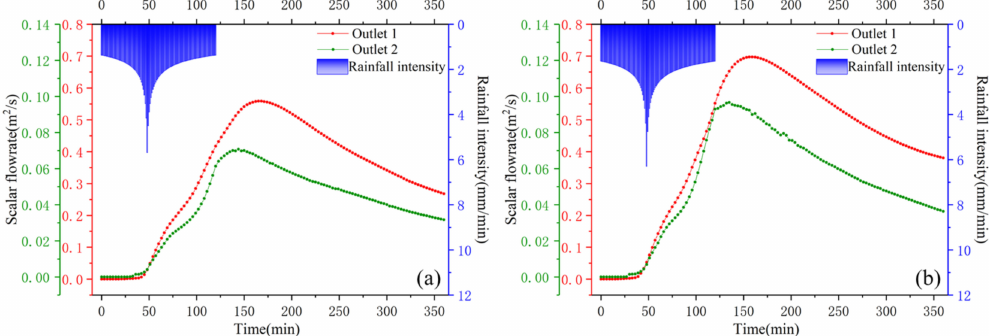
Figure 6. The river discharge process of basin outlet under different return periods. ( a ) 50-year return period; ( b ) 100-year return period.